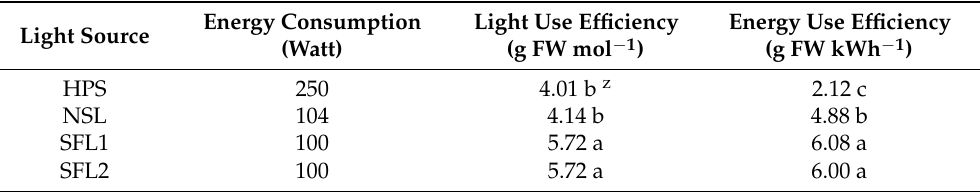
Table 4. Light and energy use efficiency of the cherry tomato plants grown with different SL sources after 7 weeks of treatment.